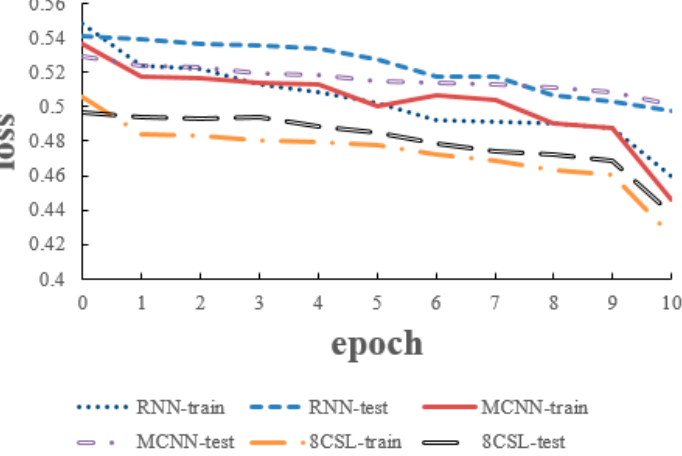
Figure 10. Loss curves of the three models on the five second data.